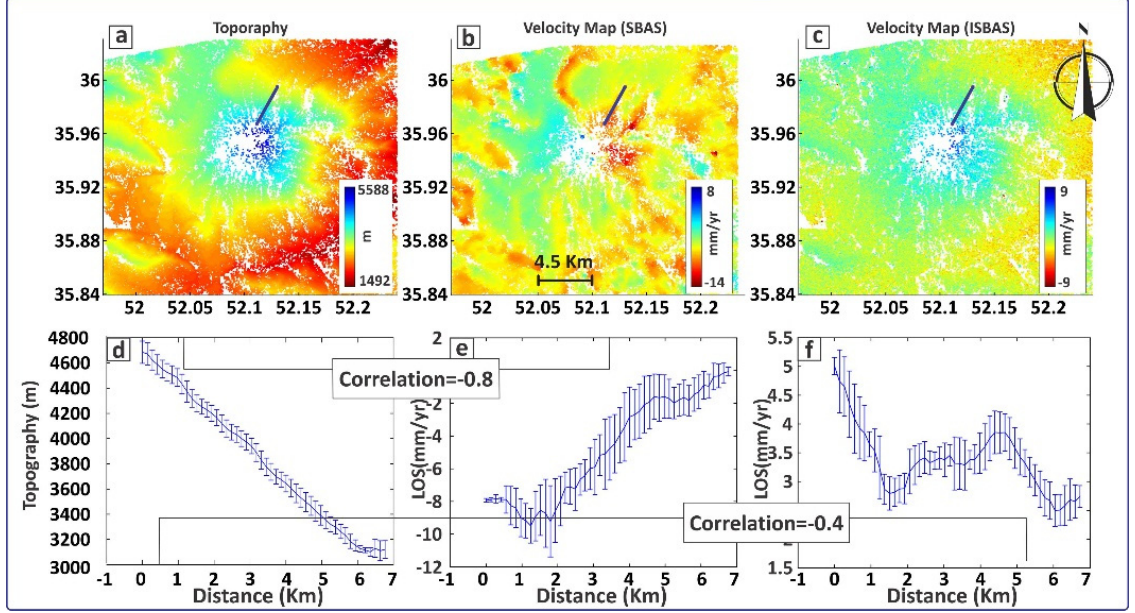
Figure 9. ( a ) Topographic map. ( b ), ( c ) are ground deformation velocity maps from ALOS dataset calculated by standard SBAS and ISBAS methods, respectively. ( d ) Topographic profile extracted from (a). ( e ) and ( f ) are displacement profile extracted from (b) and (c), respectively. Correlation coefficients were determined at a 95% confidence level.